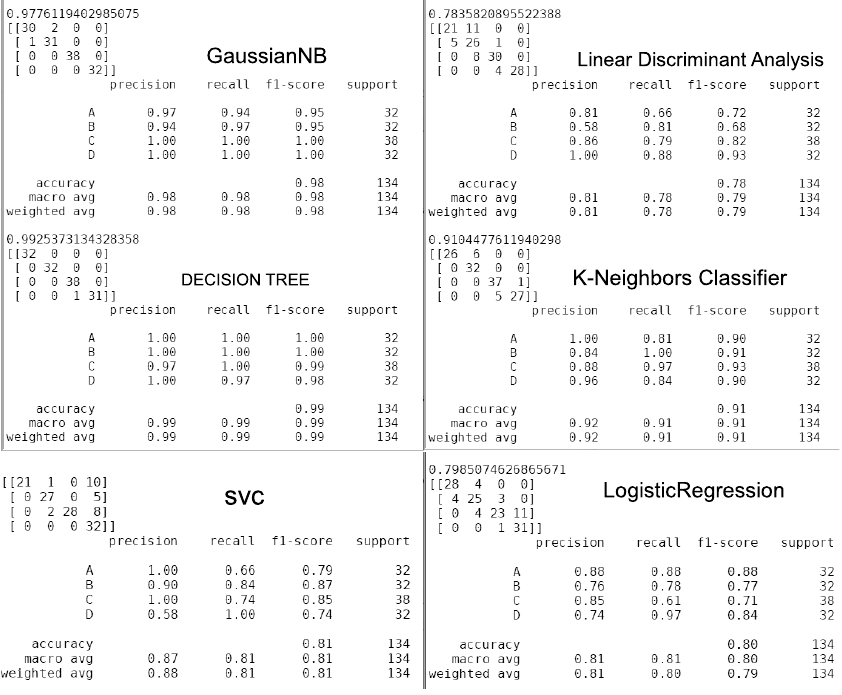
Figure 12. Results and evaluation of the classification algorithms in the third